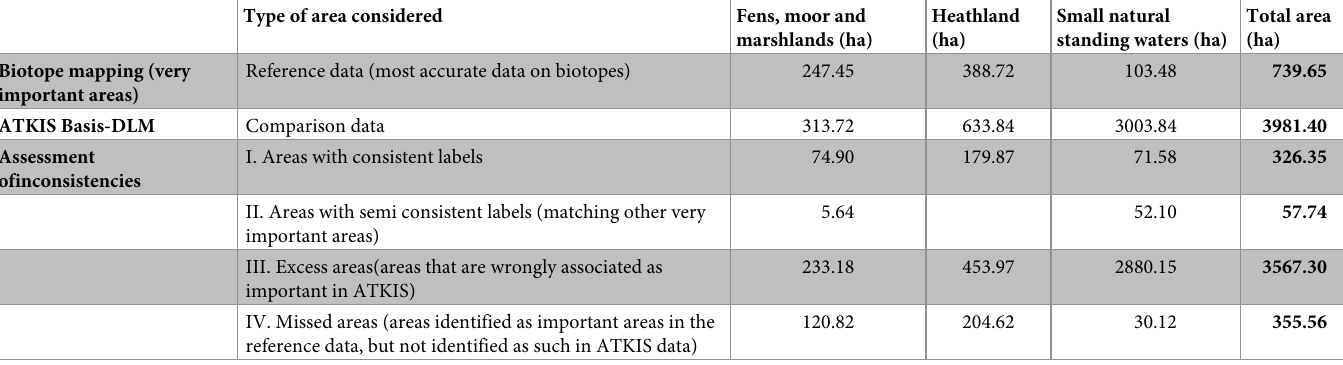
Table 3. Quantitative results of the case study ‘state-wide habitat conservation siting’. Type of area